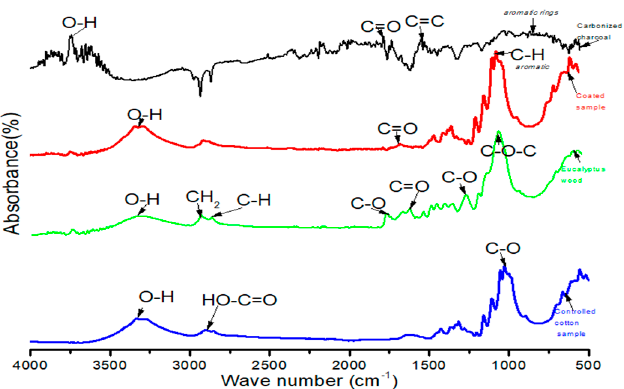
Figure 5. Infrared spectra of eucalyptus wood, charcoal, charcoal coted and controlled samples.